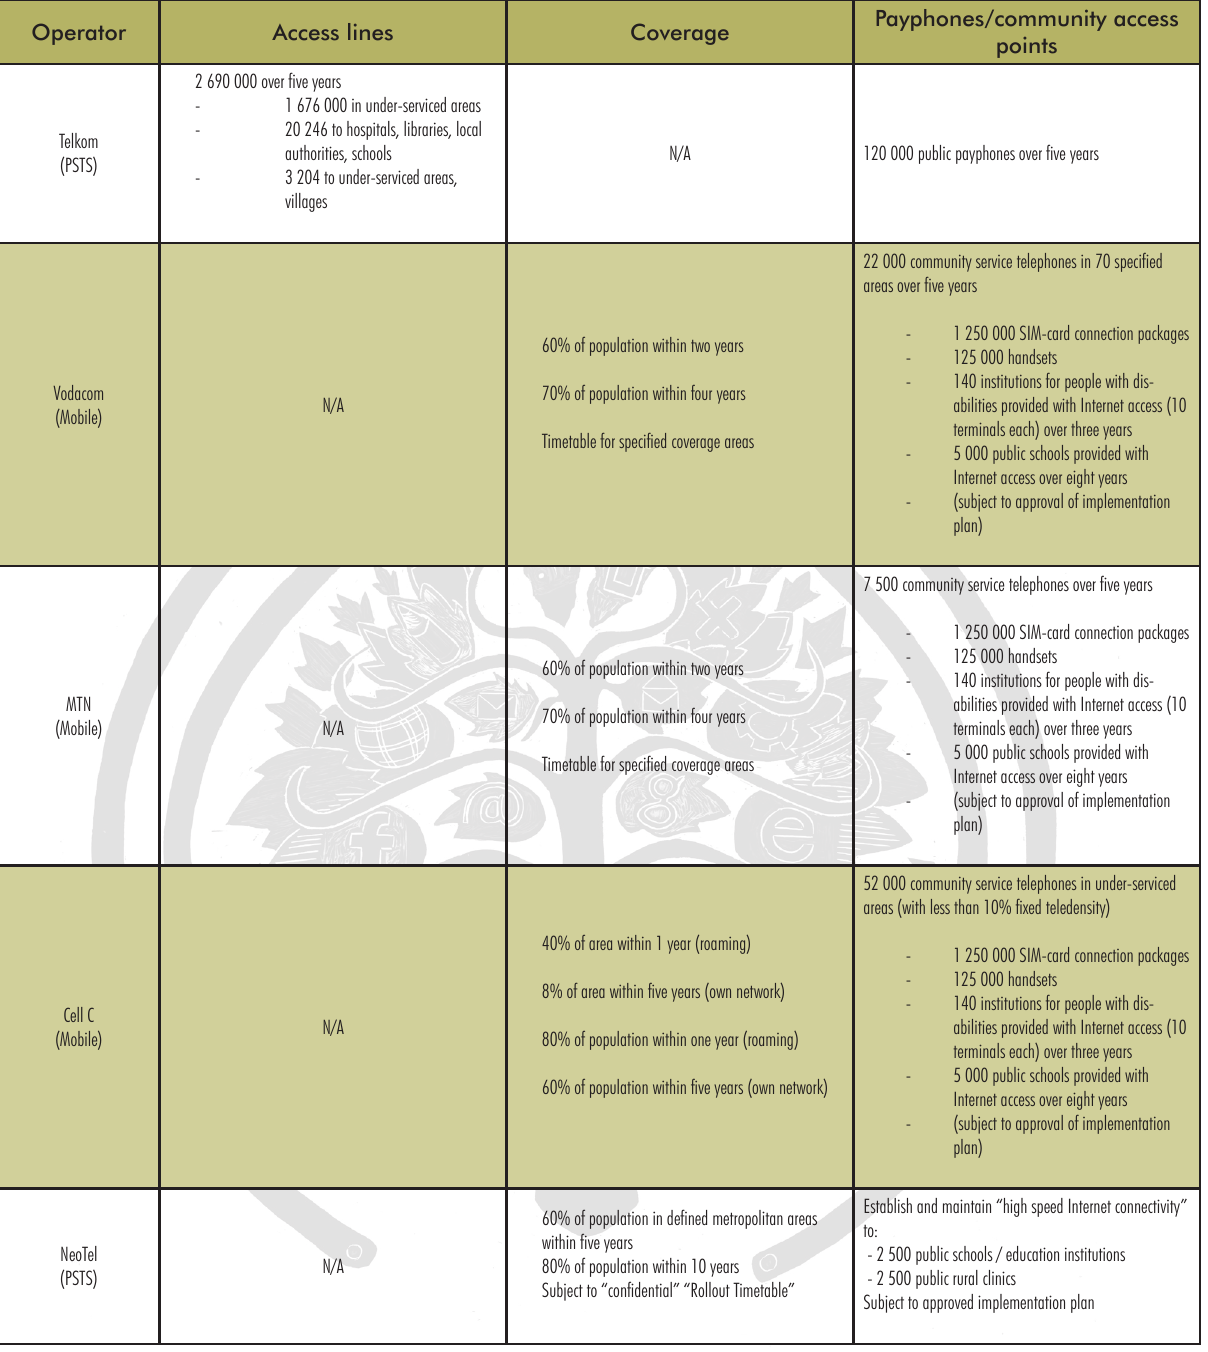
Payphones/community access